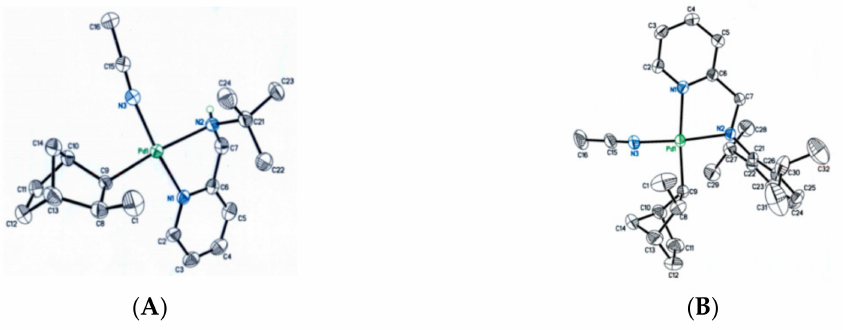
Figure 2. ORTEP drawings of ( A ) {[ t BuHNCH 2 ( o -C 6 H 4 N)]Pd[(C 7 H 10 )Me](NCMe)}(BF 4 ) ( T - 2b ); ( B ) {[(2,6- i Pr 2 C 6 H 3 )HNCH 2 ( o -C 6 H 4 N)]Pd[(C 7 H 10 )Me](NCMe)}(BF 4 )( C - 2e ); all H-atoms are omitted for clarity.